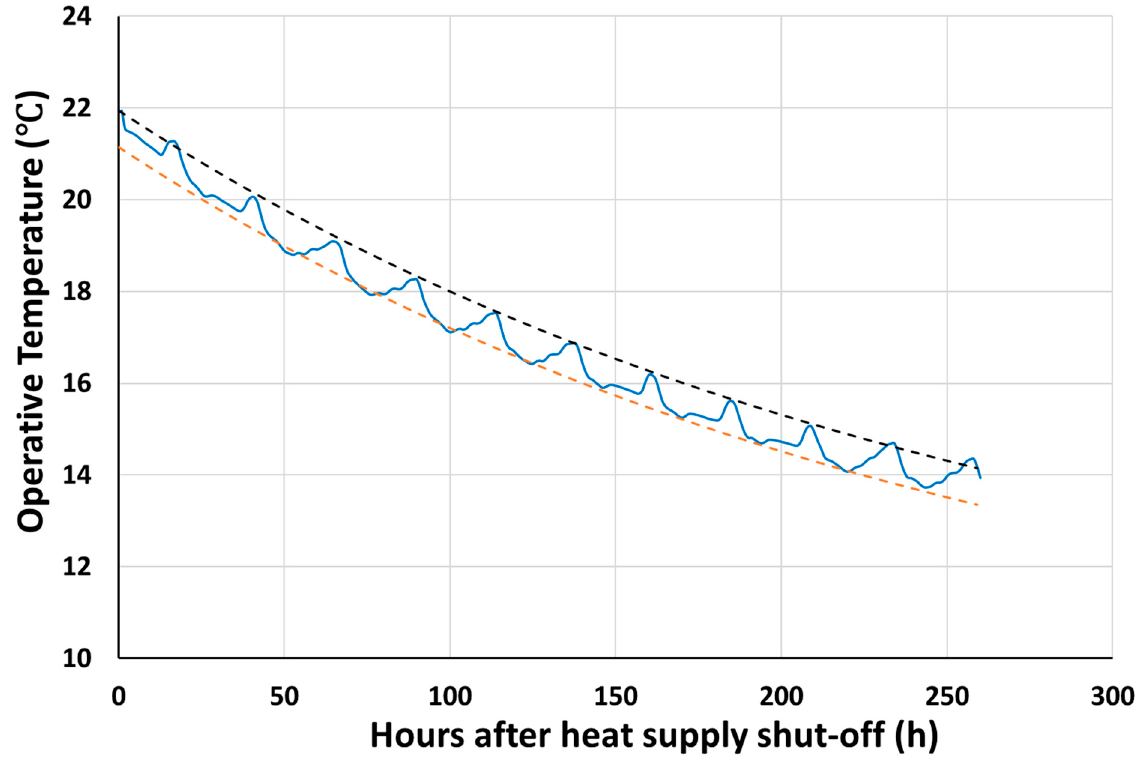
Figure 4. Temperature decay from simulations after DH shut-off. IHG causes variations in tem- perature, but decay is steadily arriving at approximately T b = 11.5 °C. Dashed lines are modelled with Equation (6), with 𝜏 (cid:3029) estimated to 260 h.